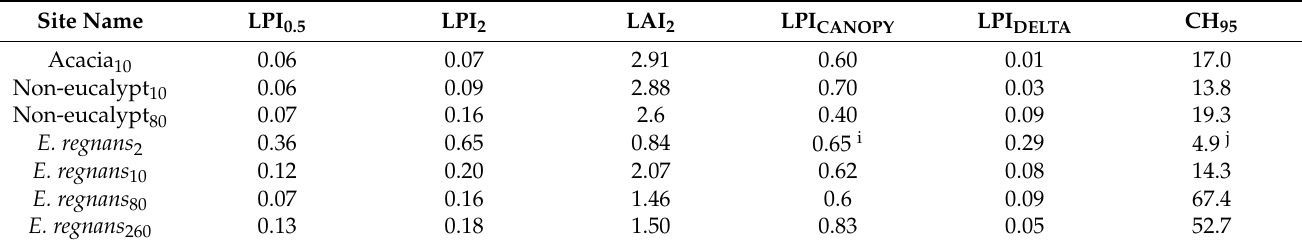
Table 2. Site forest structure and canopy height metrics derived from